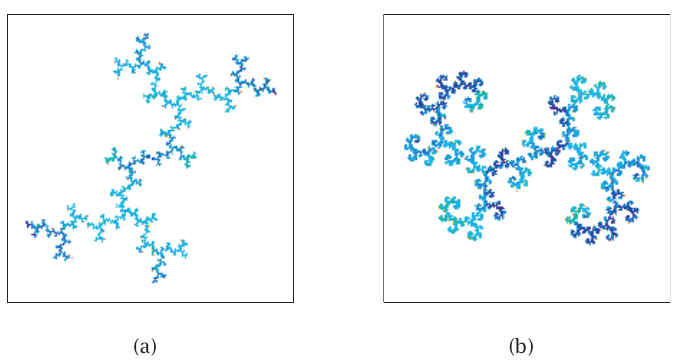
Figure 5.3 . Mixed iteration of contractive Blaschke